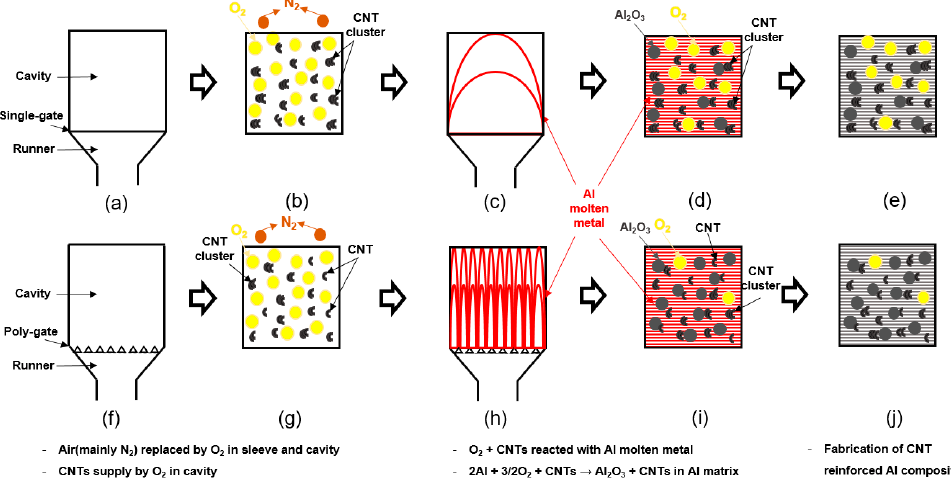
Figure 14. Schematic of fabrication of CNT-added composites cast using ( a – e ) a single gate and ( f – j ) poly gate by using ORDC.